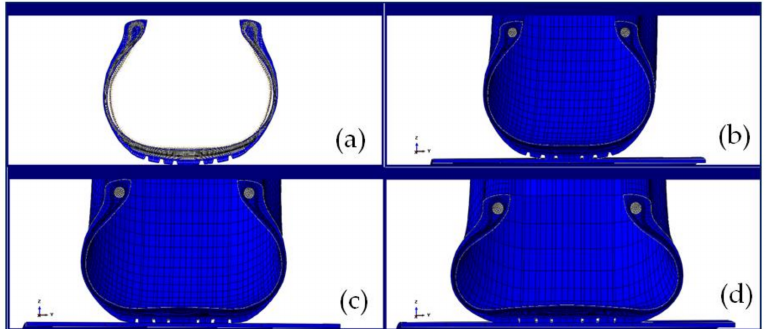
Figure 17. Numerical simulation, tire modeled with 51 elements ( a ) 2-D, deflated and inflated tire, ( b ) 3-D inflated tire pre-loaded with l 1 kN, ( c ) inflated tire loaded with l 2 = 10 × l 1 kN, ( d ) inflated tire loaded with l 3 = 25 × l 1